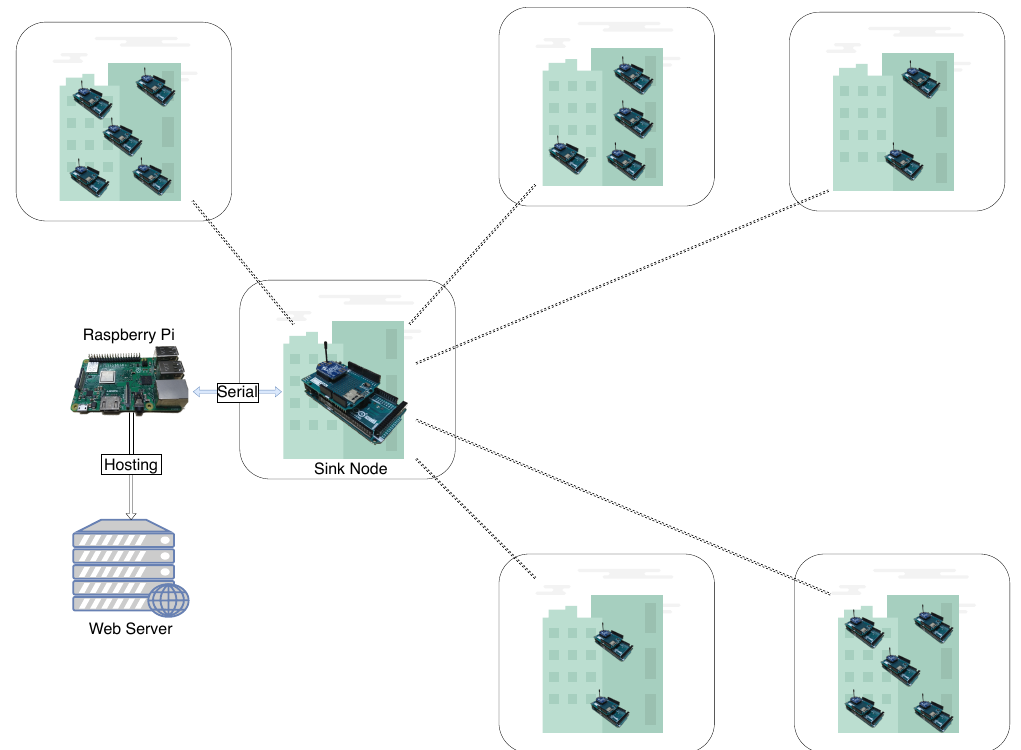
Figure 3. Depiction of the system’s architecture on the Ionian University